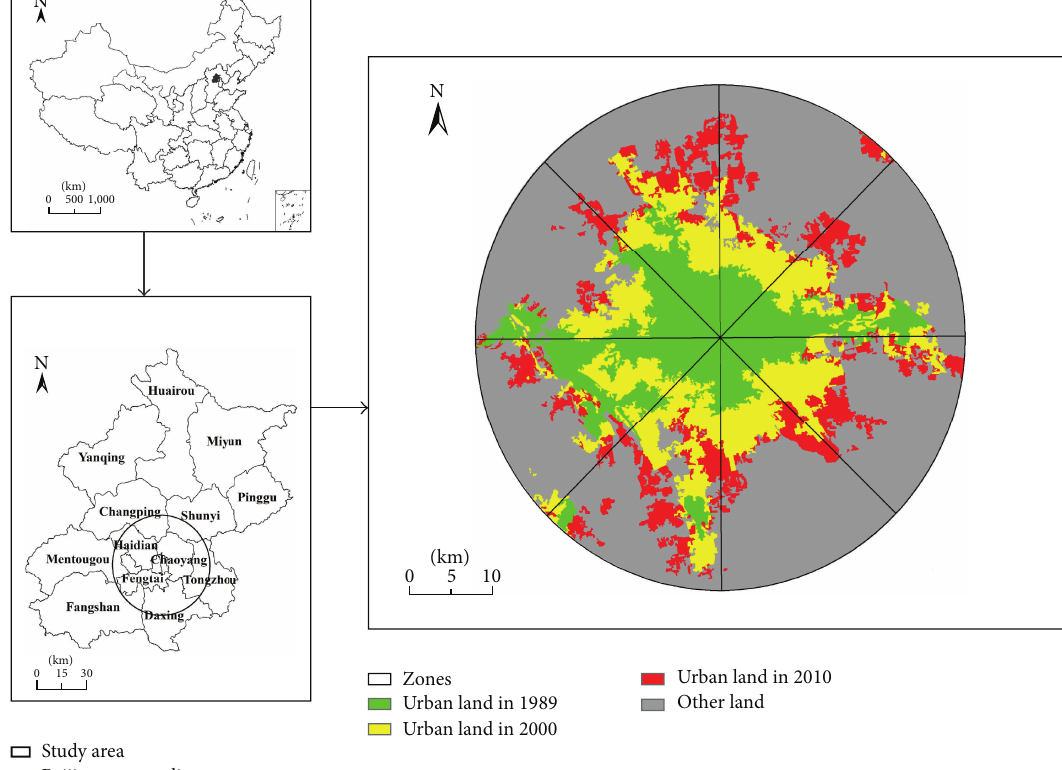
Figure 1: The spatial distribution of urban land in Beijing during